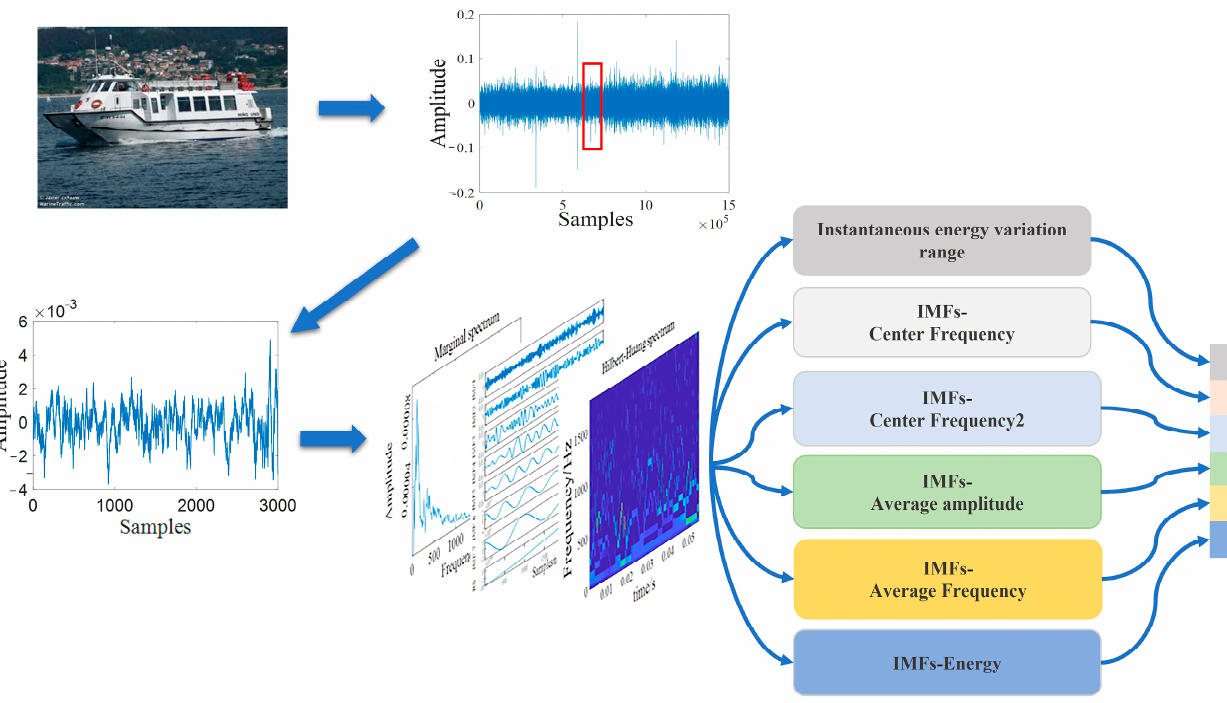
Figure 3. The process of multi ‐ scale feature extraction.